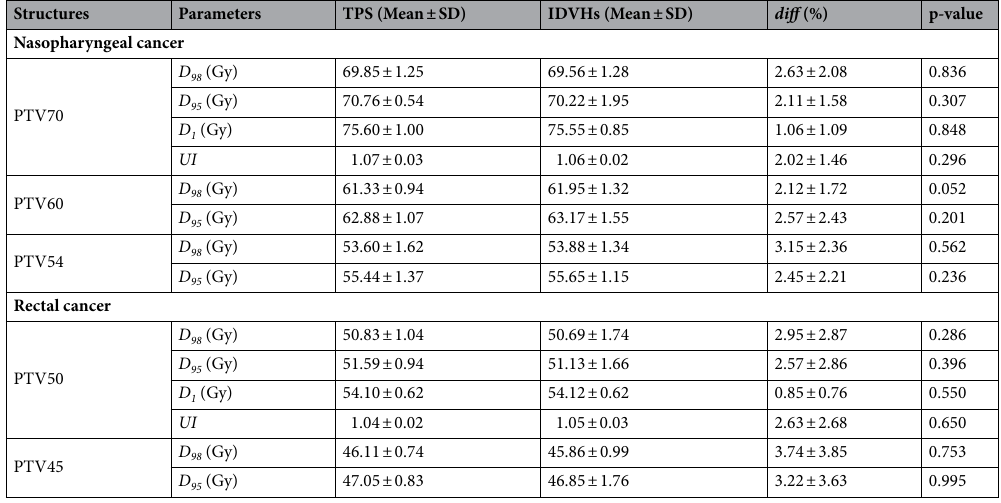
Table 5. Comparison between the PTV dose coverage achieved by the TPS and the PTV dose coverage predicted by the IDVHs method. The data shown are the means and standard deviations of the respective parameters for the 20 nasopharyngeal cancer and 15 rectal cancer patients. diff represents the mean absolute percentage difference between the PTV dose coverage achieved by the TPS and the PTV dose coverage predicted by the IDVHs method. ( diff =| P IDVHs -P TPS |/ P TPS × 100% ), where, P represents the corresponding parameter.